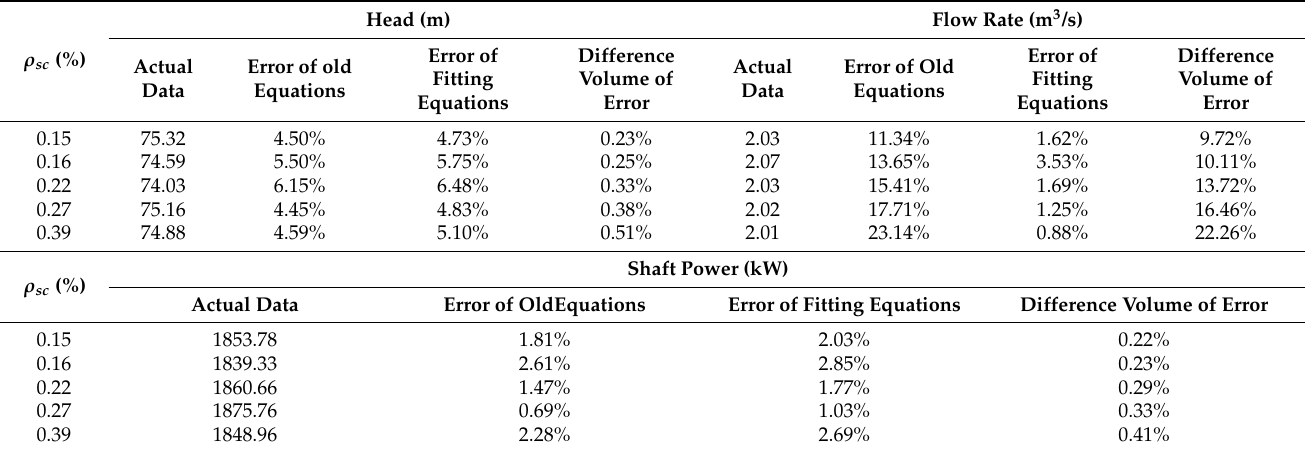
Table 7. Error analysis of old equations and fitting equations.